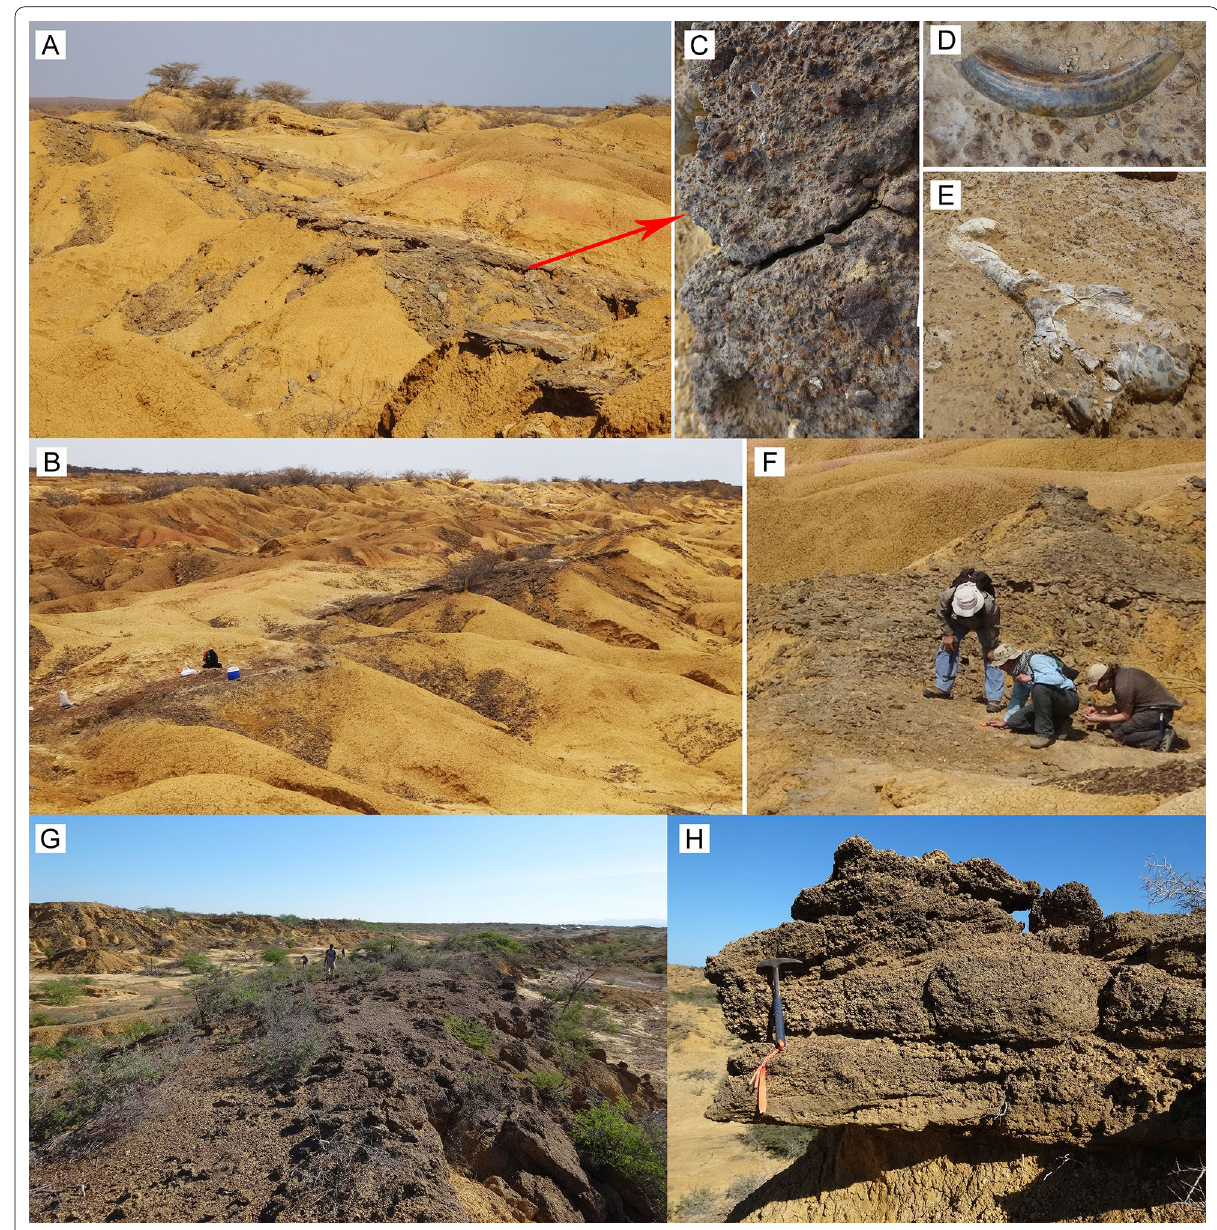
Fig. 2 Fossiliferous localities of the San Gregorio Formation outcrops. A – F Norte Casa Chiguaje locality. C Close‑up of the conglomeratic‑fossiliferous layer. D , E Tooth ( D ) and humerus ( E AMU‑CURS‑62) of mammals in situ. G , H San Gregorio Oeste del Pueblo locality. H Example of the conglomeratic layers were disarticulated continental vertebrates remains were found. Pictures from authors JDCB ( A – D , G , H ) and EAC ( F